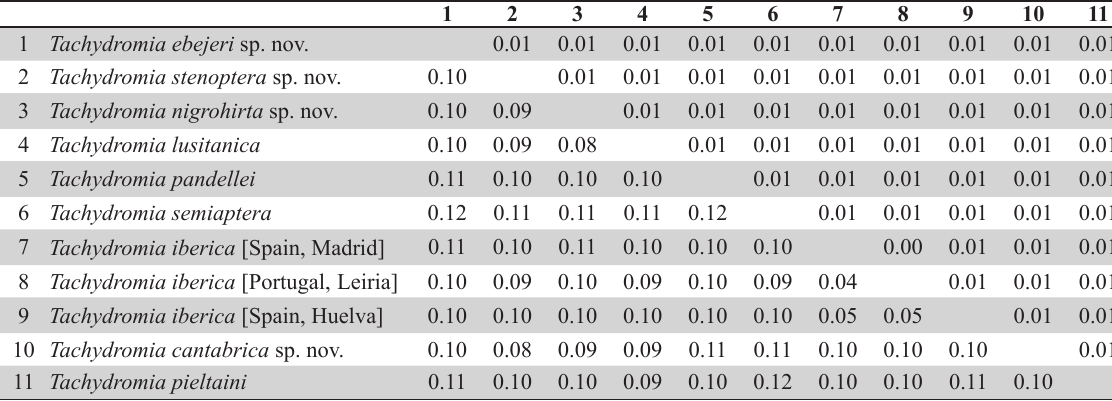
Table 5. Mean sequence divergence (uncorrected p-distances) of COI, between pairs of species of the Iberian ant-like Tachydromia Meigen, 1803 (calculated in MEGA7). Standard error estimates are shown above the